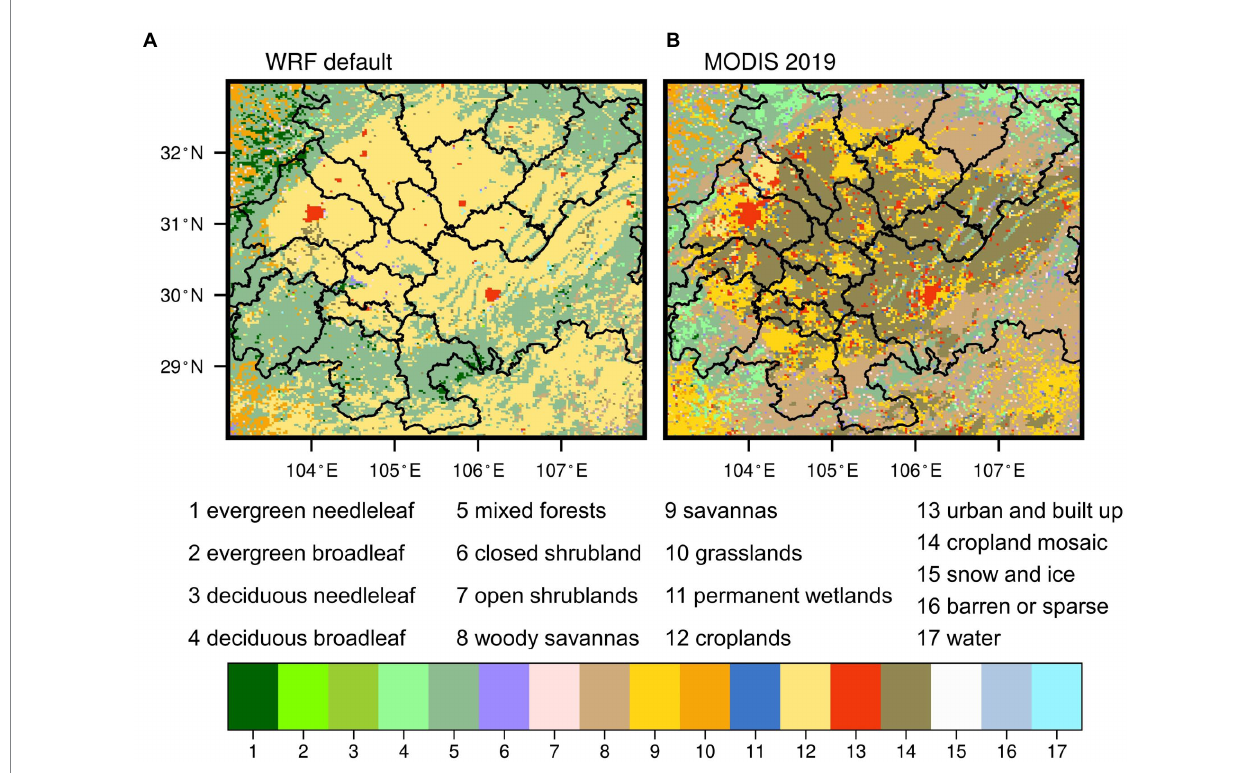
FIGURE 2 Land use classification in WRF model over Sichuan Basin (A) WRF default data (B) MODIS MCD12Q1 for